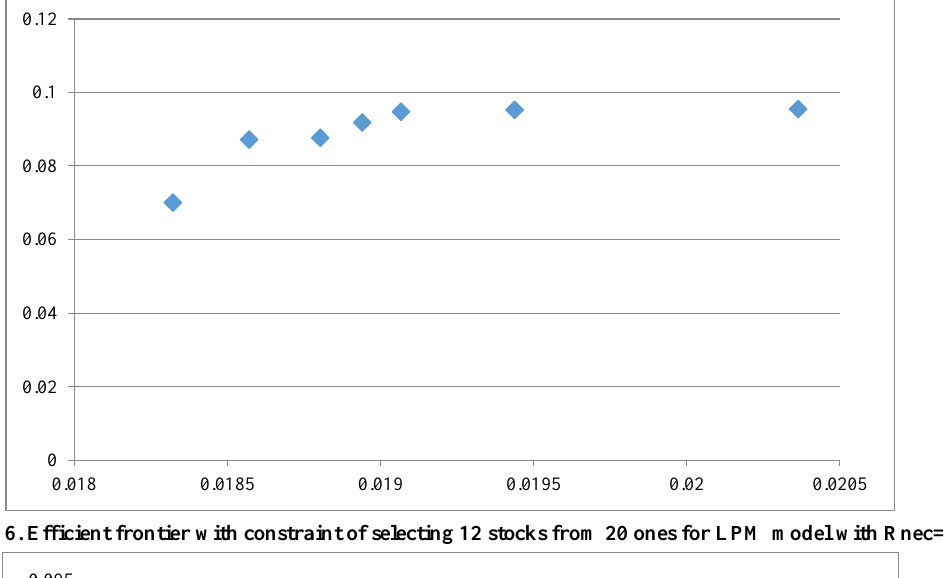
Figure 6. Efficient frontier with constraint of selecting 12 stocks from 20 ones for LPM model with Rnec= 0.